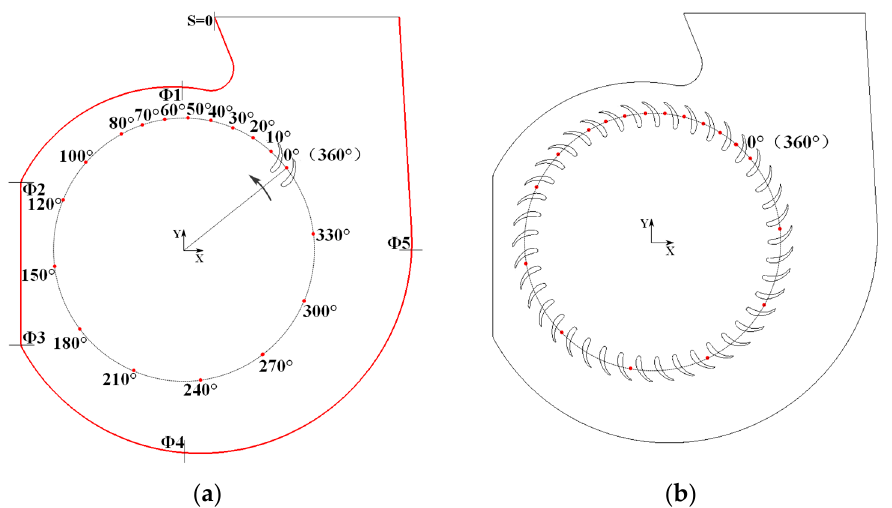
Figure 14. ( a ) Positions for the transient motion of the fixed point where pressure is recorded in URANS simulation; ( b ) positions where pressure is recorded in RANS simulation.